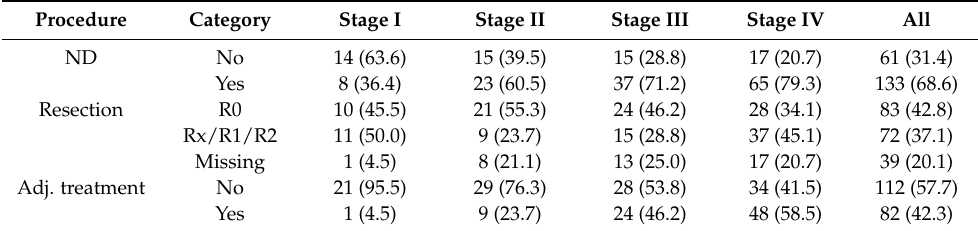
Table 5. Procedural characteristics by